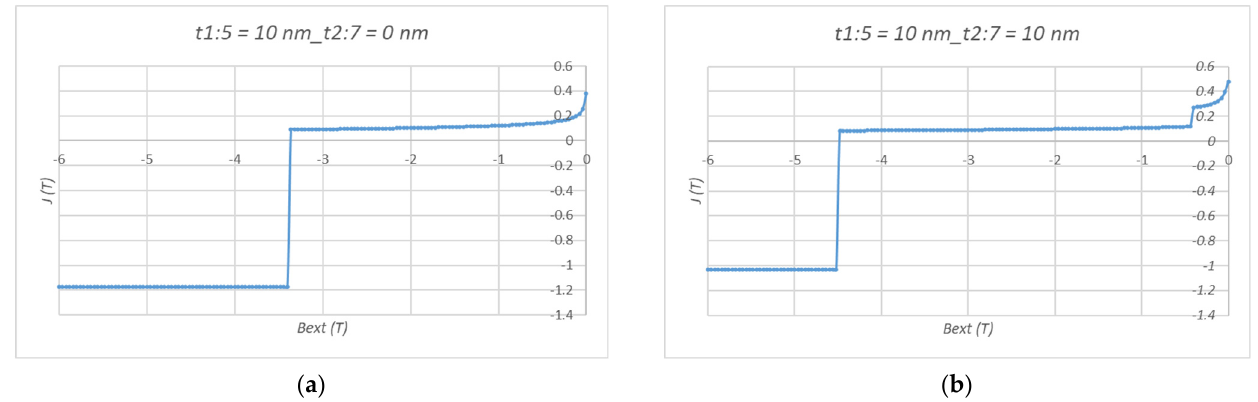
Figure 2. Simulated demagnetization curves of the initial sandwich model ( a ) and modified sand- wich model with the 2:7R phase layer ( b ) of (Sm, Zr)(Co, Cu, Fe)z